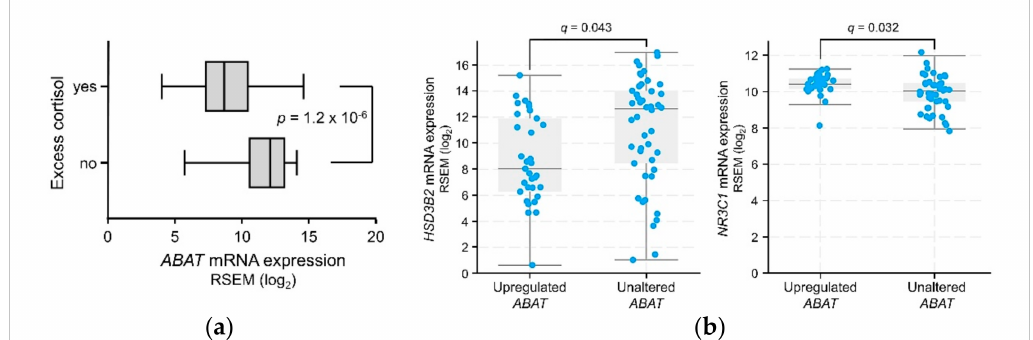
Figure 4. Relationships between ABAT transcript levels and steroid phenotype of ACC tumors. ( a ) Box-and-whisker plot of ABAT transcript expression levels in ACC patient tumors, separated by Excess Adrenal Hormone History Type (TCGA Firehose Legacy); dotted lines represent median expression levels. “Yes” n = 33; “No” n = 41. ( b ) Expression levels of HSD3B2 and NR3C1 , in